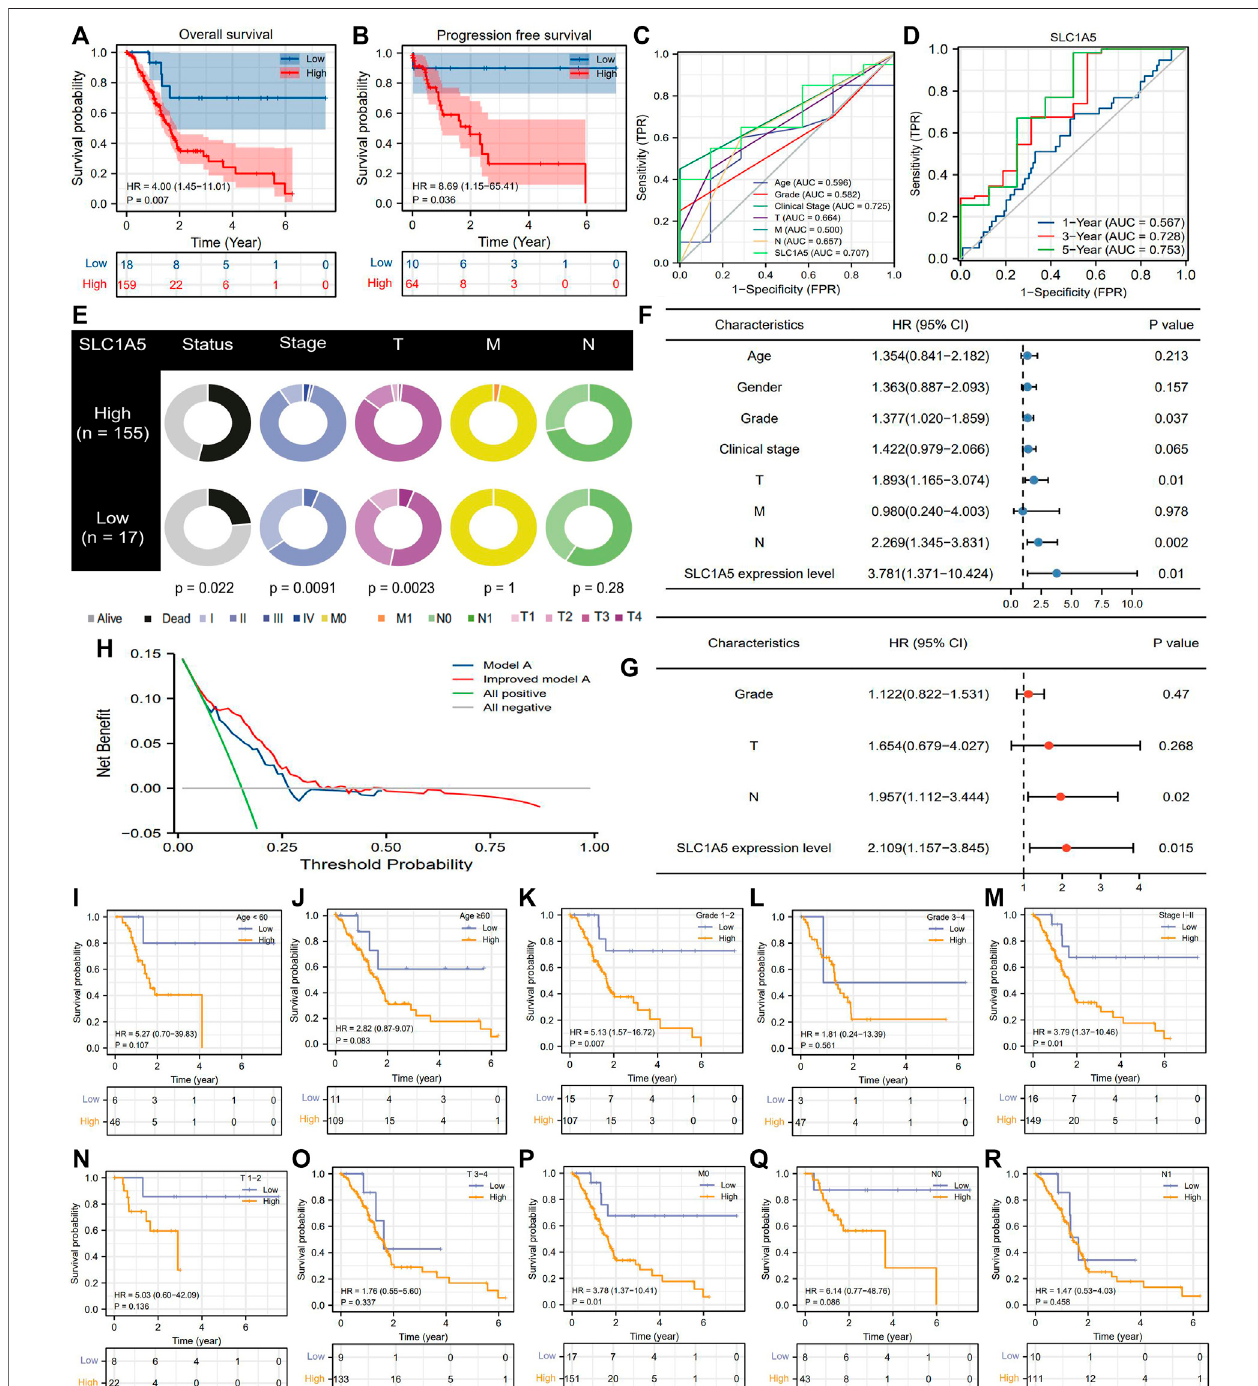
FIGURE3| SLC1A5possessesagreatprognosticvalue. (A) OSdifferencebetweenhigh-andlow-SLC1A5-expressiongroups.(B)PFSdifference. (C) ROCs. (D) Time-independentROCs. (E) TherelationshipbetweenSLC1A5expression andclinicopathologicalfeaturesofPAAD. (F,G) Independentprognosticanalysesbasedon the multivariate and univariate cox regression methods. (H) DCA results. “ Model A ” represents the traditional prognostic model consisting of age, gender, histological grade,andclinicalstage(blueline). “ ImprovedmodelA ” representstheprognosticmodelconsistingofage,gender,histologicalgrade,clinicalstage,andSLC7A11 expression (red line). (I – S) Clinical subgroup analyses. OS, overall survival; PFS, progression-free survival; ROC, receiver operating characteristic curve; PAAD, pancreatic adenocarcinoma; DCA, decision curve analysis.